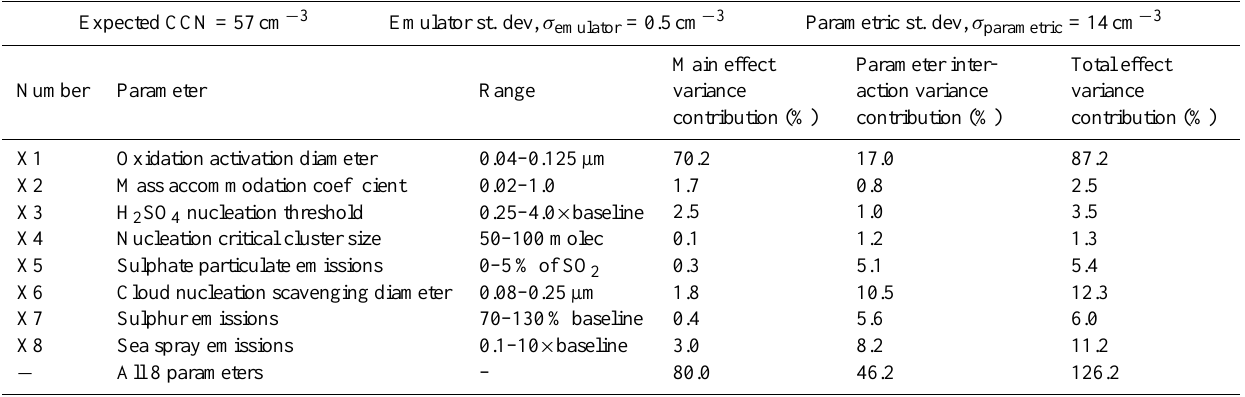
H 2 SO 4 nucleation